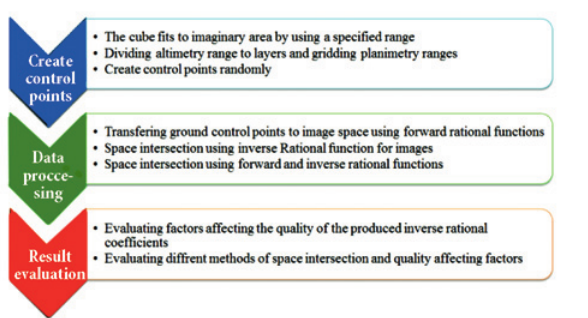
Fig. 1.Step-by-step instructions of proposed method for conversion of forward RPCs to the inverse ones